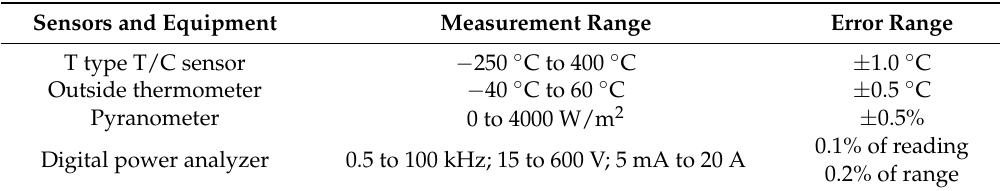
Table 2. Specification of sensors and equipment for the experiment.